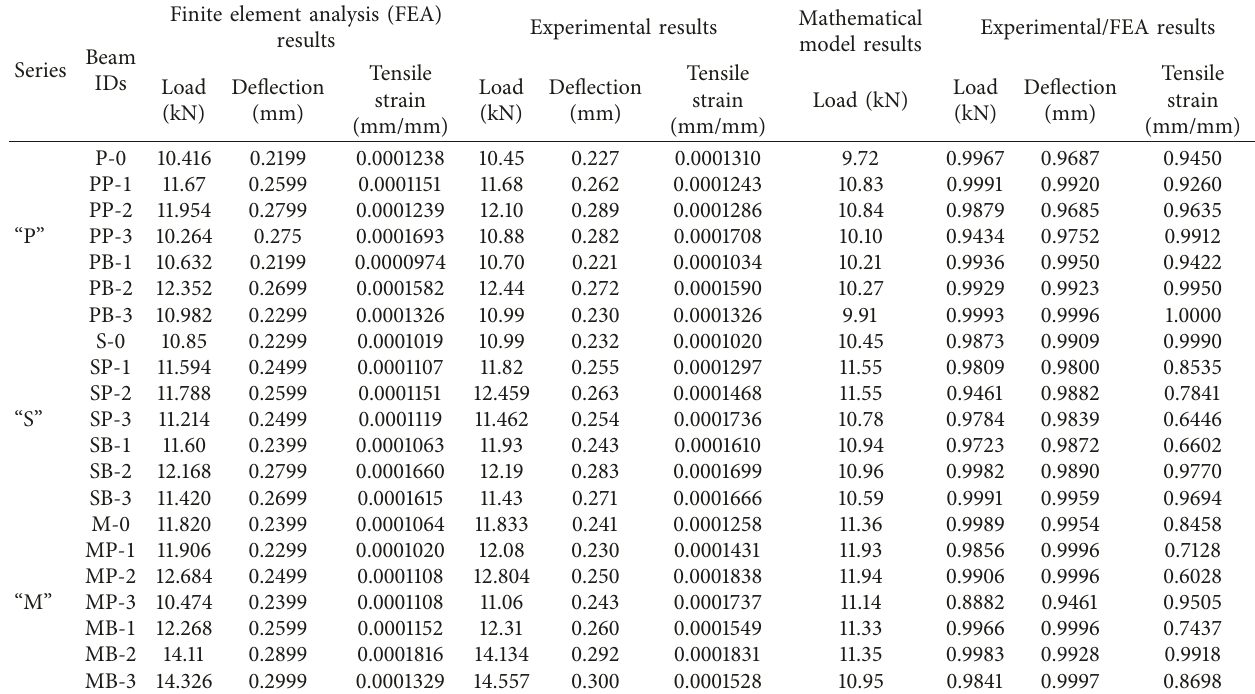
Figure 7: Typical crack pattern at beam Table 7: Comparison of finite element (FE) analysis and experimental results.